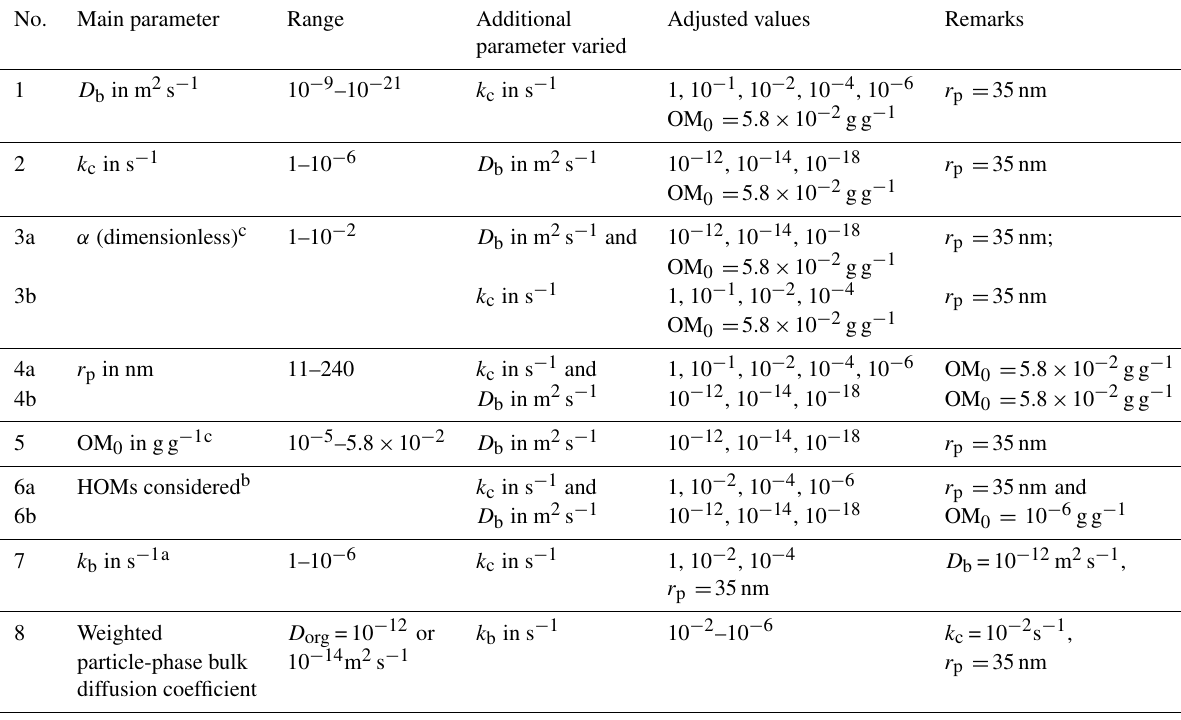
Table 1. Varied model parameters in the sensitivity studies, where some cross-checks concerning the sensitivity have been conducted.